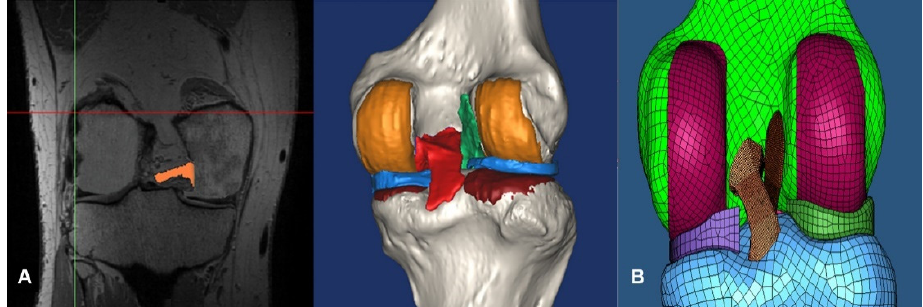
Figure 2. ( A ) A three-dimensional soft-tissue reconstruction based on magnetic resonance imaging (MRI); articular cartilage, both menisci, patellar tendon, and four ligaments (anterior cruciate, posterior cruciate, medial collateral, and lateral collateral ligaments). ( B ) Generation of the finite element model (FEM) using Hypermesh 8.0 (Altair Engineering, Inc., Troy, MI, USA).